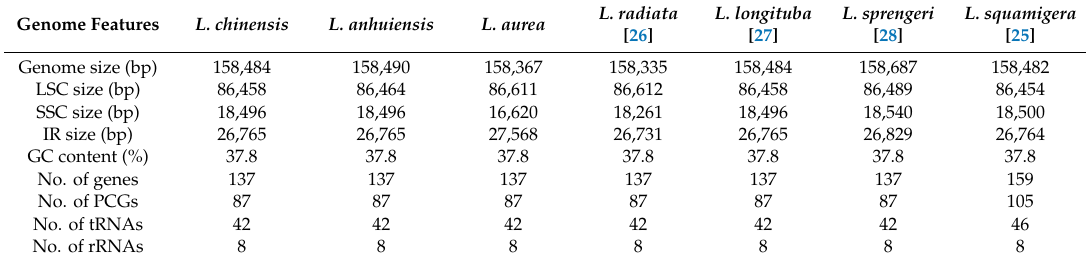
Table 1. Summary of seven chloroplast genomes of Lycoris